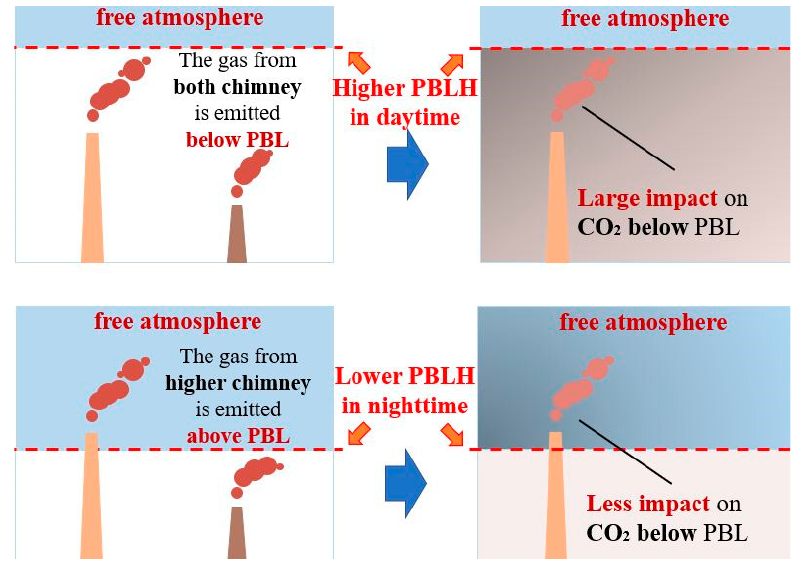
Figure 2. Revised model framework in simulating atmospheric CO 2 concentration by coupling dynamic PBLH variations and chimney